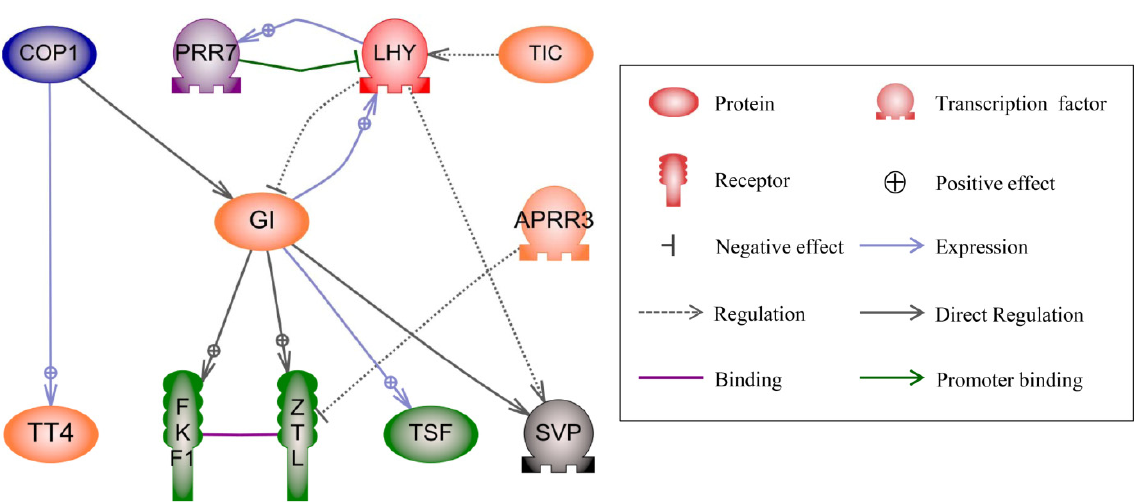
Figure 5. Gene regulatory network in three hybrid combinations. DGs in three hybrid combinations were used for direct interaction analysis by Pathway Studio 9.0. Interaction searching includes promoter binding, expression, regulation and binding. LHY, LATE ELONGATED HYPOCOTYL; PRR7, PSEUDO-RESPONSE REGULATOR 7; SVP, SHORT VEGETATIVE PHASE; TIC, TIME FOR COFFEE; GI, GIGANTEA; ZTL, ZEITLUPE; APRR3, PSEUDO-RESPONSE REGULATOR 3; FKF1, FLAVIN-BINDING, KELCH REPEAT, F-BOX 1; TSF, TWIN SISTER OF FT; COP1, CONSTITUTIVELY PHOTOMORPHOGENIC 1; TT4, TRANSPARENT TESTA 4. Black, dark green, navy refers to protein are encoded by DGs in LY2163 , LY2186 and LYP9 respectively; dark magenta refers to protein are encoded by DGs in LY2163 and LYP9 ; orange refers to protein are encoded by DGs in LY2186 and LYP9 ; red refers to protein are encoded by DGs in LY2163 , LY2186 and LYP9